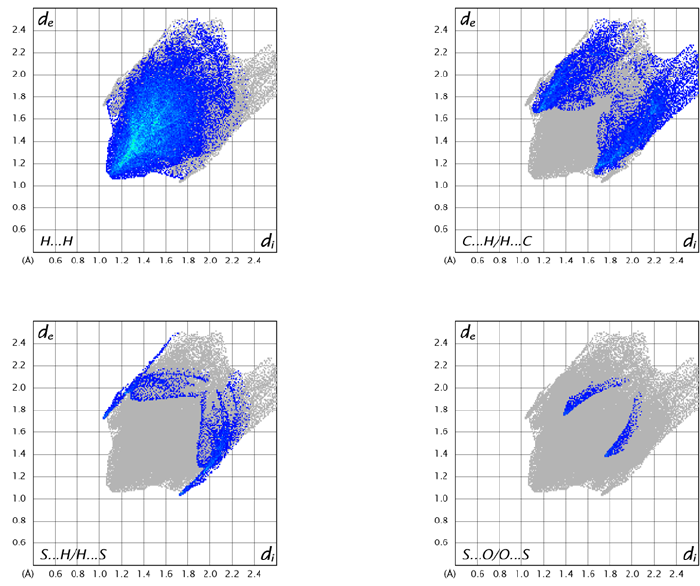
Figure 9. This is a figure. Schemes follow the same formatting.